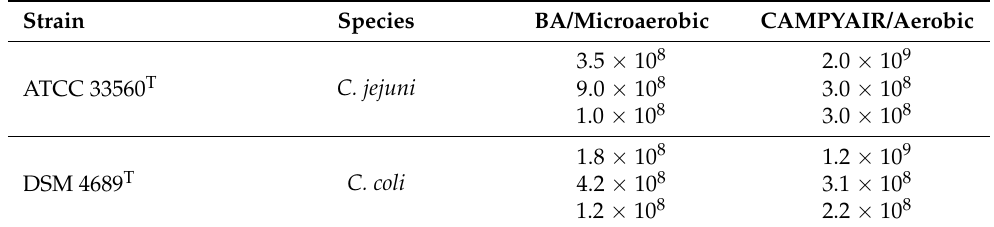
Table 2. Quantitative growth (CFU/mL) of strains C. jejuni (ATCC 33560 T ) and C. coli (DSM 4689 T ) on BA incubated under microaerobic conditions and on CAMPYAIR incubated under aerobic con- ditions. Bacteria were enumerated using the Miles and Misra method.